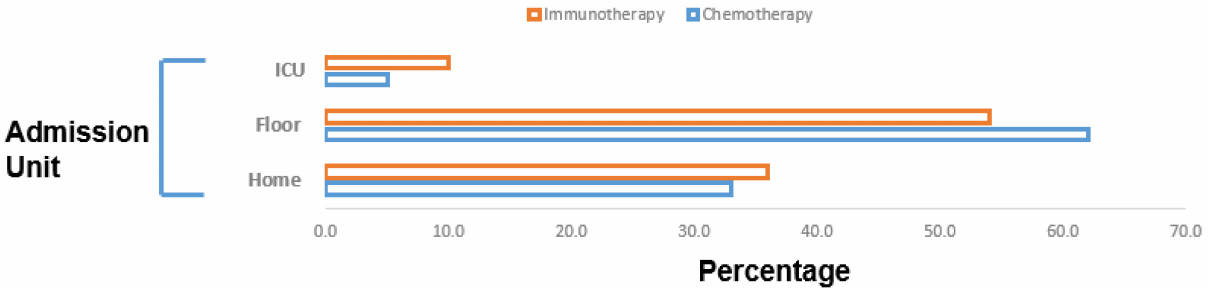
Figure 3. Admission unit of COVID-19-affected patients ( n = 121). In total, 32 (53.0%) of the immunotherapy patients required hospitalization and 6 (11.0%) were admitted to the ICU. For the patients on chemotherapy, 34 (56.0%) required hospitalization and 3 (5.0%) needed specialized care in the